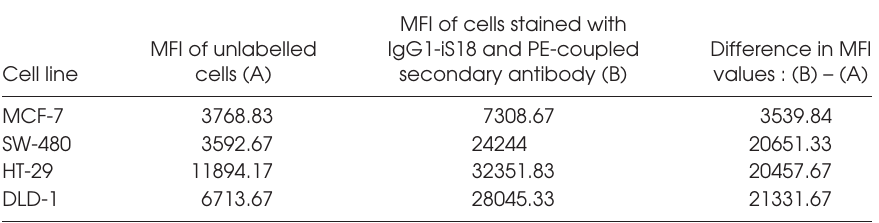
Table 1. Median fluorescence intensity (MFI) values used as an indicator of differential expression of LRP/LR on the surface of MCF-7, SW-480, HT-29 and DLD-1 cells. MFI of cells stained with MFI of unlabelled IgG1-iS18 and PE-coupled cells (A) secondary antibody (B)